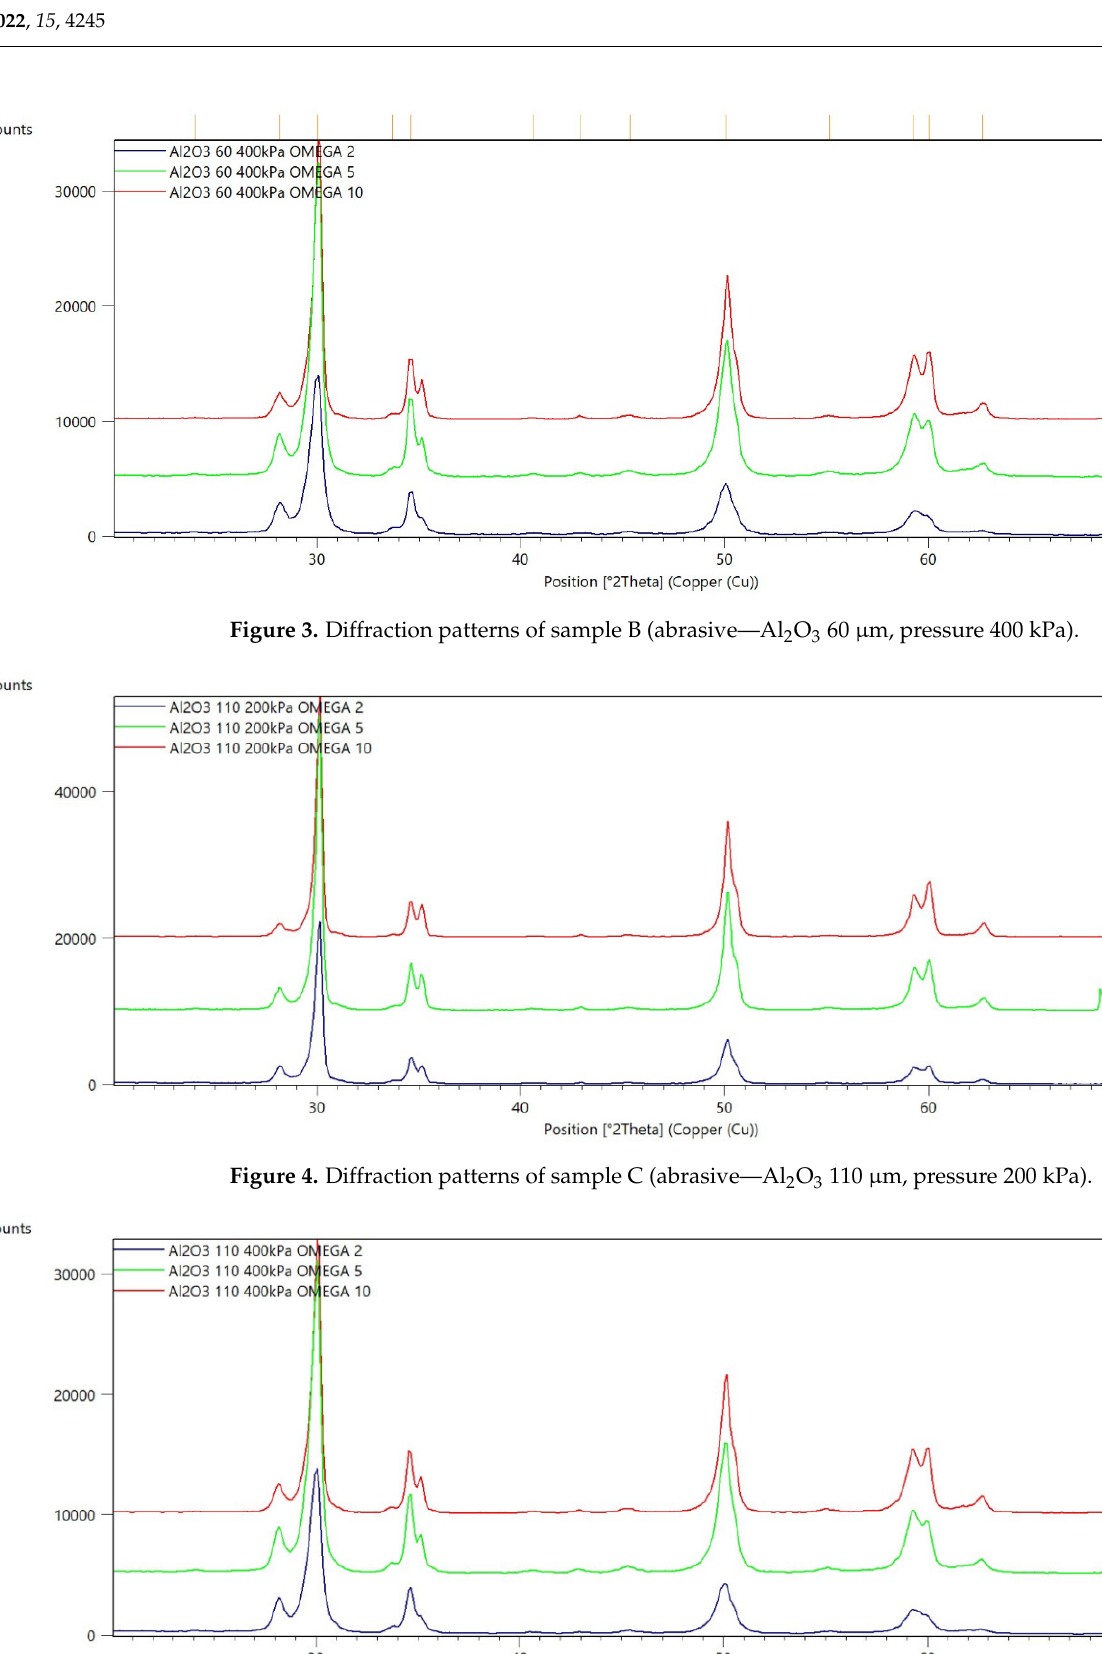
Figure 6. Diffraction patterns of sample E (abrasive—Al 2 O 3 250 μ m, pressure 200 kPa). Figure 7. Diffraction patterns of sample F (abrasive—Al 2 O 3 250 μ m, pressure 400 kPa).